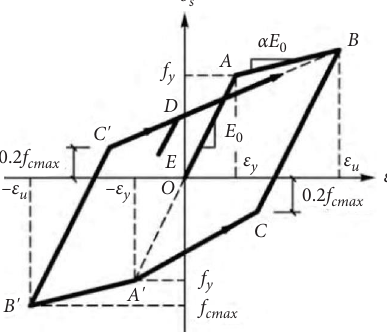
Figure 2: Concrete constitutive